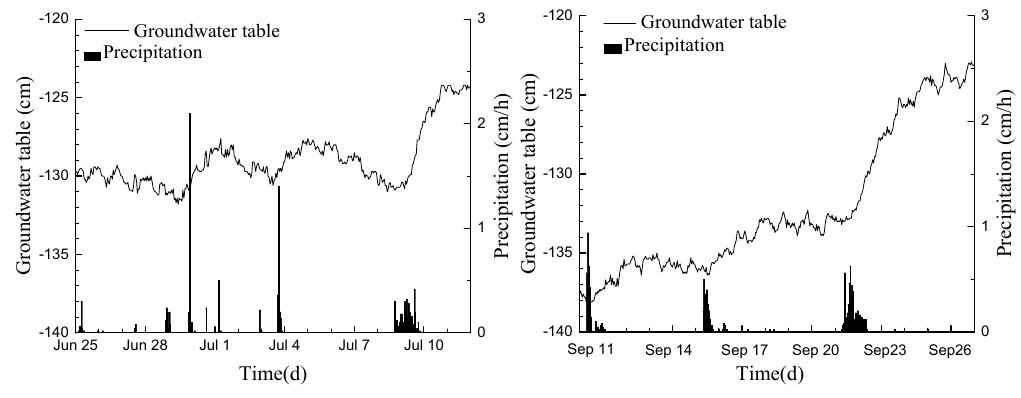
Figure 6. Water table and precipitations in